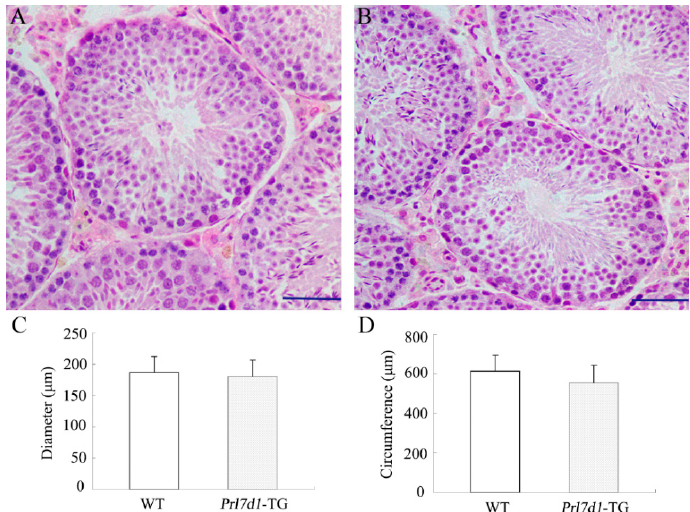
Figure 2. Histological analyses of testis from four-month-old wild-type (WT) ( A ) and Prl7d1 transgenic ( Prl7d1 -TG) mice ( B ). Sections were stained with hematoxylin and eosin. The scale bar is 50 µ m; ( C ) The diameter of the seminiferous tubules and ( D ) the circumference of the seminiferous tubules were normal in Prl7d1 transgenic mice. Results for each measurement are expressed as the means ˘ SD from a minimum of 60 randomly-selected seminiferous tubules from six mice of each